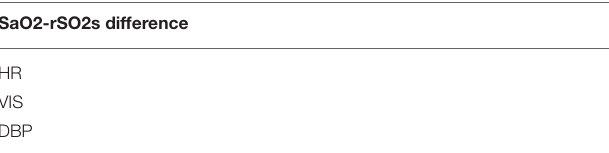
TABLE 5 | Variables associated with cardiac arrest in multivariable logistic regression model. SaO2-rSO2s difference HR VIS